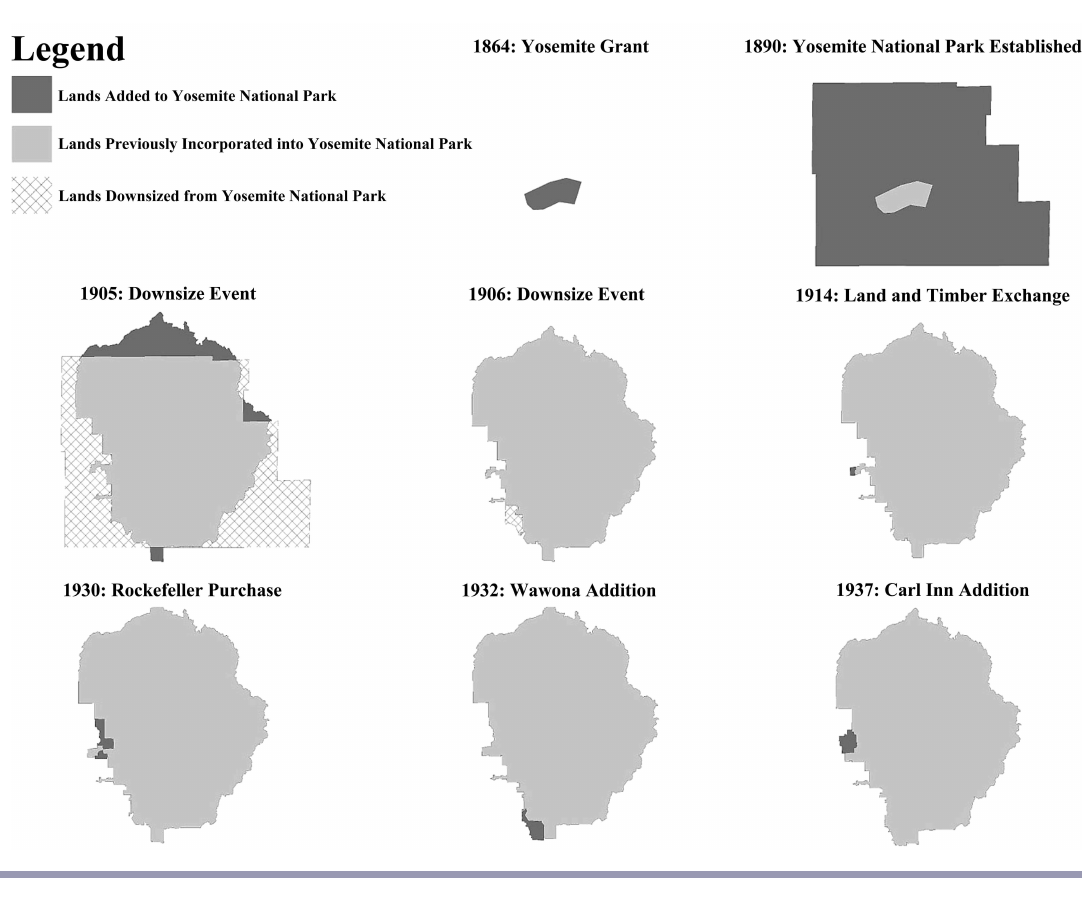
Fig. 2 . Boundary changes of Yosemite National Park, 1890 – 1937